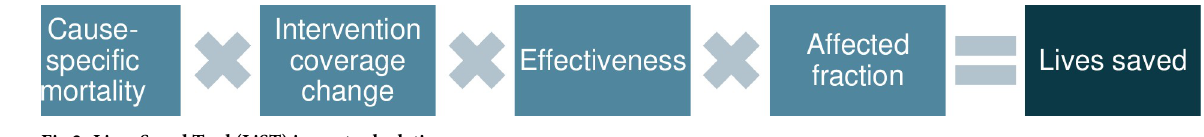
Fig 2. Lives Saved Tool (LiST) impact